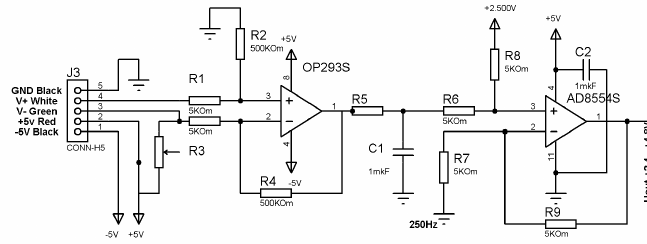
Fig. 6. Schematic diagram of an electronic load cell EX601D connected to a data acquisition